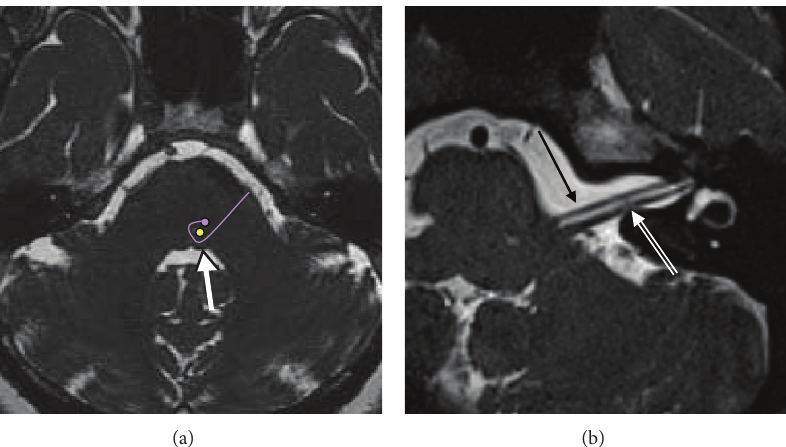
Figure 1: Normal facial nerve on MRI. (a) Axial CISS image at the level of the pons demonstrates the facial colliculus (arrow) seen as a small bump along the anterior wall of the fourth ventricle. This is formed by the motor tracts of the facial nerve (purple curved line) coursing around the abducens nucleus (yellow dot). (b) Axial CISS sequence of the left CPA and IAC demonstrates the normal cisternal and intracanalicular segments of the left CN VII (solid arrow), anterior to CN VIII (double lined